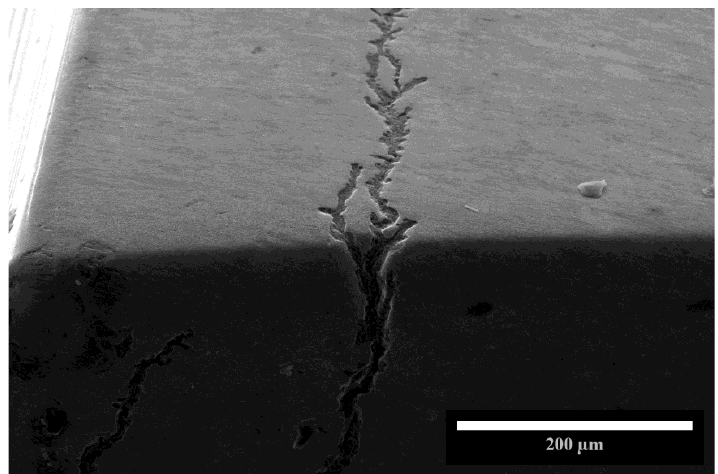
Figure 5. Longitudinal crack on the surface of the material.